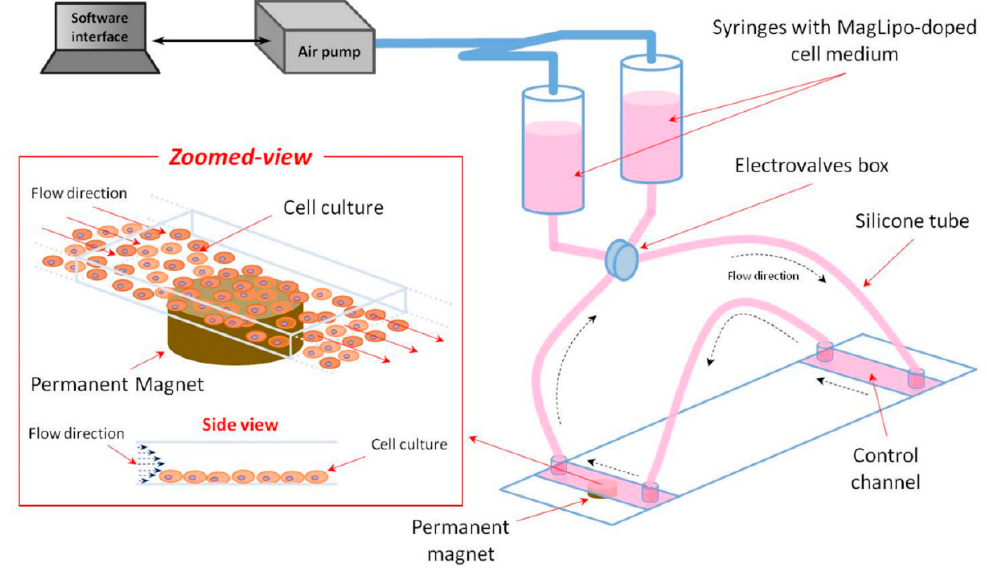
Figure 2. Schematization of the set-up for magnetic targeting experiments.